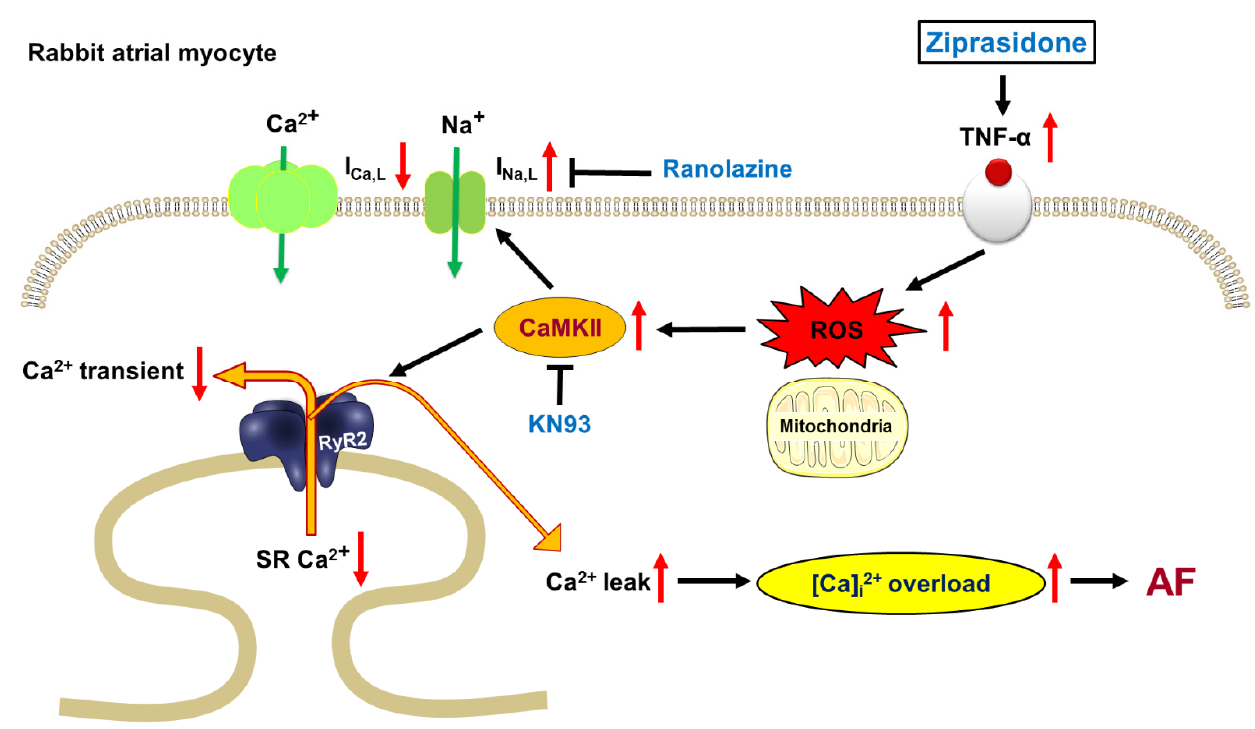
Figure 7. Proposed mechanism for ziprasidone-induced AF. TNF- α were upregulated in ziprasidone-treated myocytes, which induced cytosolic and mitochondrial ROS production. The increased ROS production activated CaMKII, leading to enhanced I Na,L and increased SR Ca 2+ leak. As a result, intracellular Ca 2+ was overloaded, promoting AF.